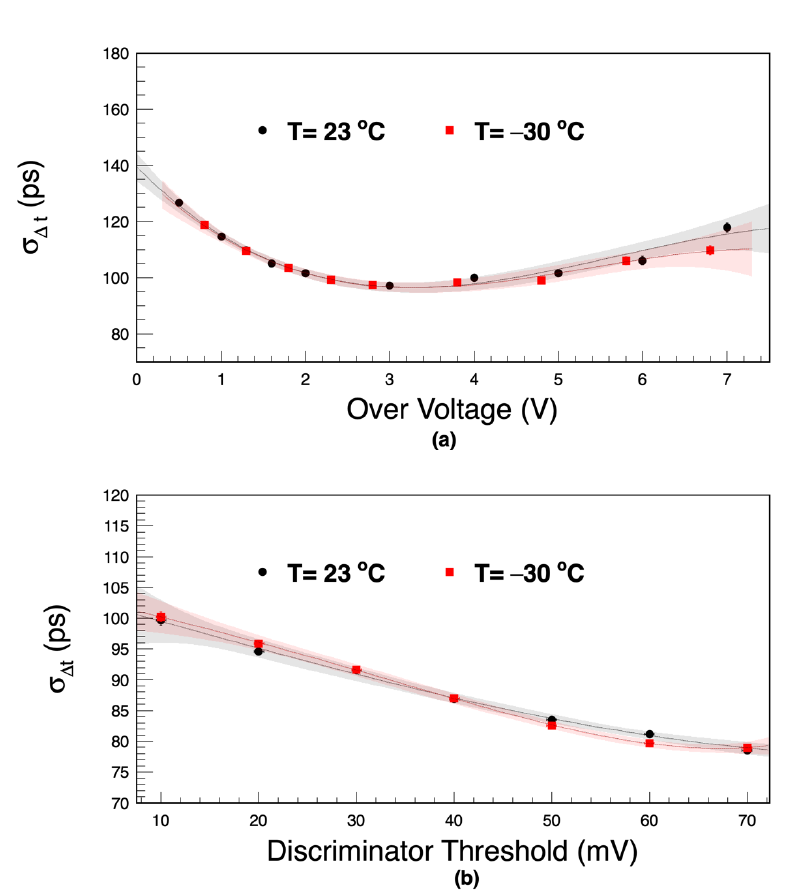
Figure 14. CTR for two different temperatures as a function of overvoltage ( a ) and as a function of the discriminator threshold ( b ). The gray and red error bands indicate the 95% confidence level of the fits in both